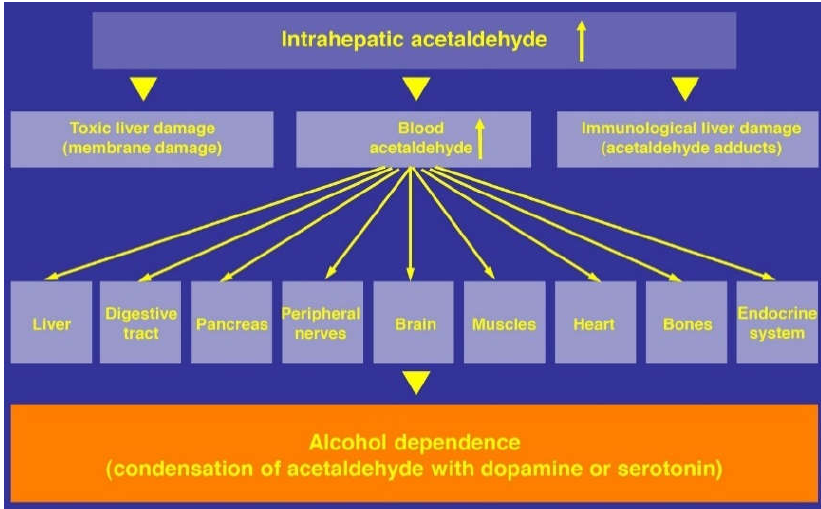
Figure 6. Hypothesis of a vicious circle of acetaldehyde in the liver. Acetaldehyde is increasingly generated from ethanol through MEOS, which is adaptively induced in activity following chronic ethanol consumption. Increased acetaldehyde levels in the liver in turn impair mitochondrial functions, including the activity of mitochondrial acetaldehyde dehydrogenase, which again likely enhances hepatic acetaldehyde concentrations at least temporarily, representing a vicious circle. Discussed and presented as a figure in a previous report [46], and reproduced with permission of the Publisher